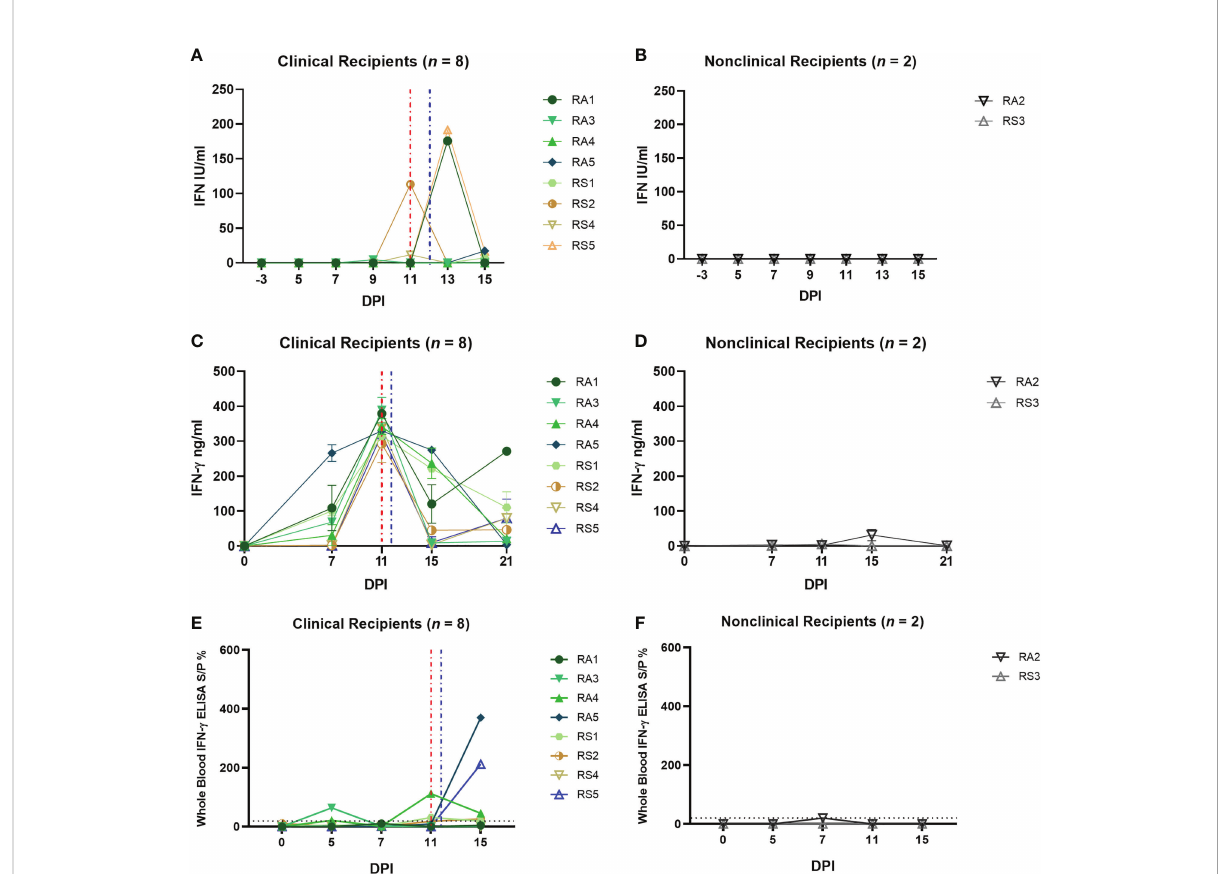
FIGURE 7 Arthropod – inoculated clinical calves but not nonclinical calves develop a uniform and robust LSDV – speci fi c CMI response as measured by IGRA on puri fi ed PBMCs. The amount of type I IFN in the sera of needle – inoculated cattle at indicated timepoints post infection (A, B) was quanti fi ed using a cellular reporter system (MxCAT assay). IGRAs were performed on PBMC puri fi ed from heparinised blood collected at indicated timepoints from clinical (C) and nonclinical (D) calves. PBMCs were stimulated overnight with UV – inactivated LSDV, supernatant collected, and IFN – g quanti fi ed using an in – house ELISA. The error bars represent the SEM. An IGRA was also performed on stimulated whole blood from clinical (E) and nonclinical (F) calves at the timepoints indicated. Whole blood was stimulated with live LSDV overnight, then IFN – g present in the plasma quanti fi ed using a commercially available ELISA. The error bars represent the SEM. The dotted horizontal line represents a 15 S/P % positive cut – off. Red dotted line represents the onset of lesions for group RS cattle and the blue dotted line for group RA cattle. Data corrected to mock PBS